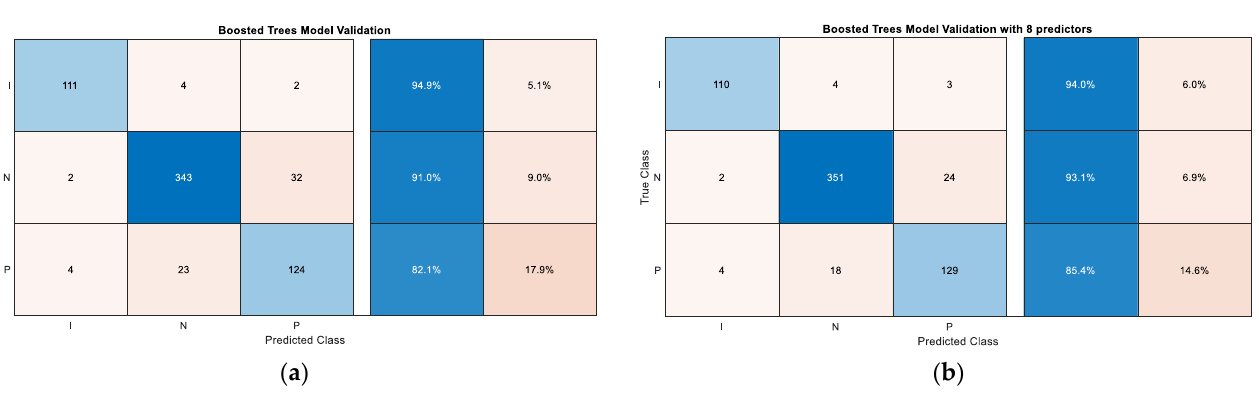
( b ) Figure 9. ( a ) Confusion matrix of the Boosted Trees model after training using the 8 predictors with